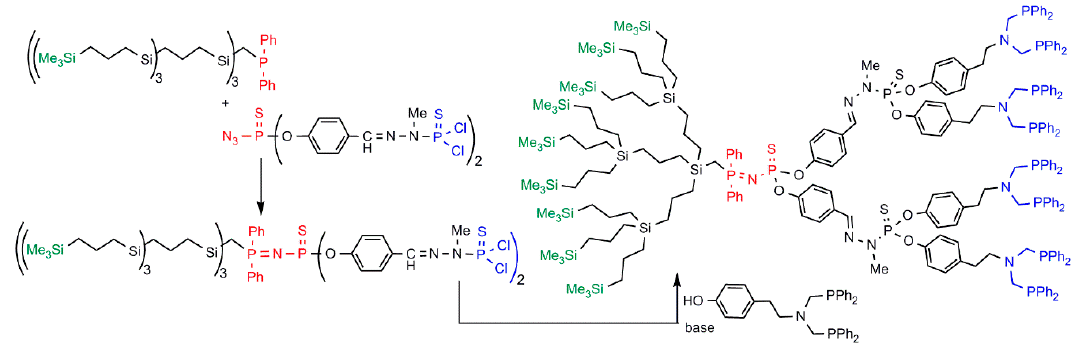
Figure 9. Synthesis of a Janus dendrimer by “click” Staudinger reaction, then functionalization on one side.